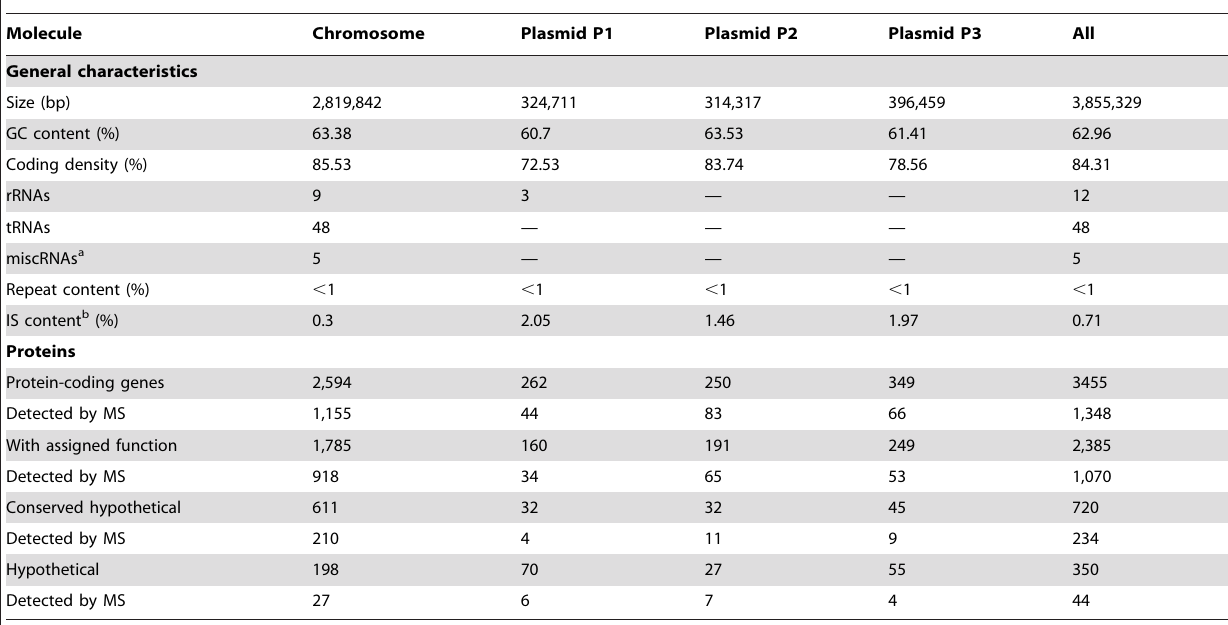
Table 1. General characteristics of the D. deserti genome.